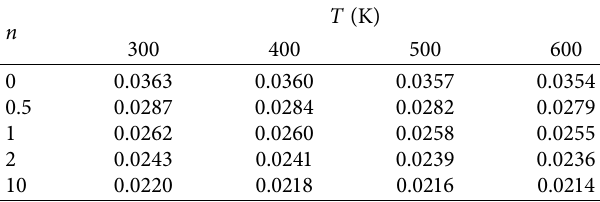
Table 5: First nondimensional natural frequencies ϖ of Si